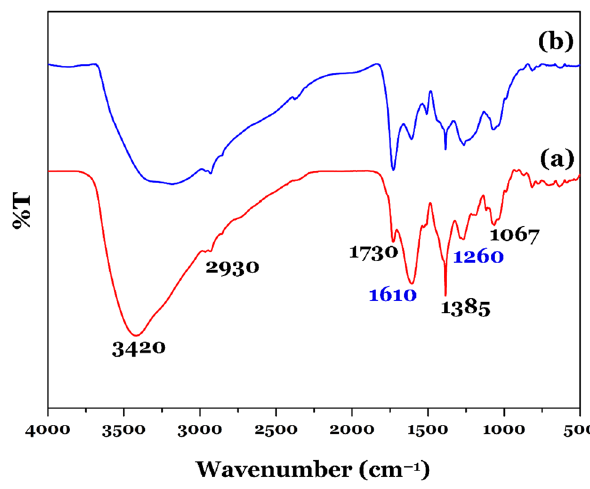
Figure 2: FTIR spectra of ( a ) C. hindsii extract and ( b ) Au - NPs -